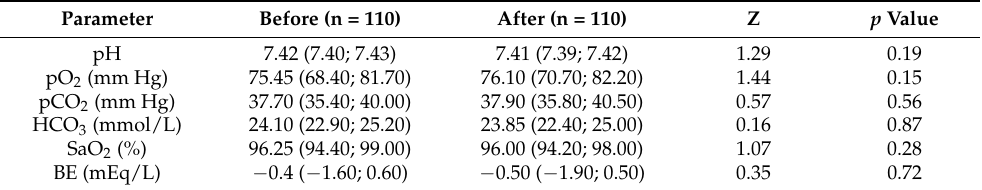
Table 2. Arterial blood gas analysis of participants before and after taking care of COVID-19 patients in isolation